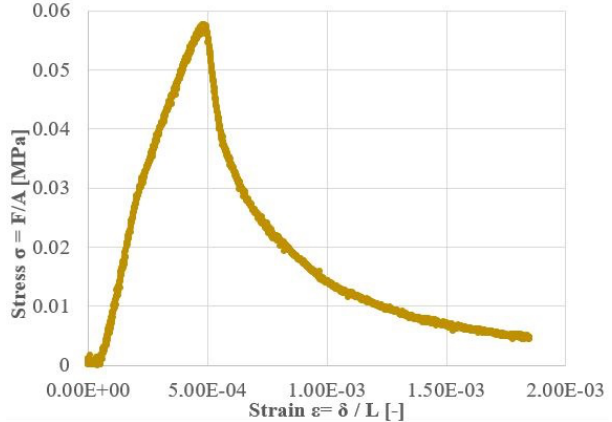
Figure 5. The stress-strain curve for AGL III spec- imen numb.